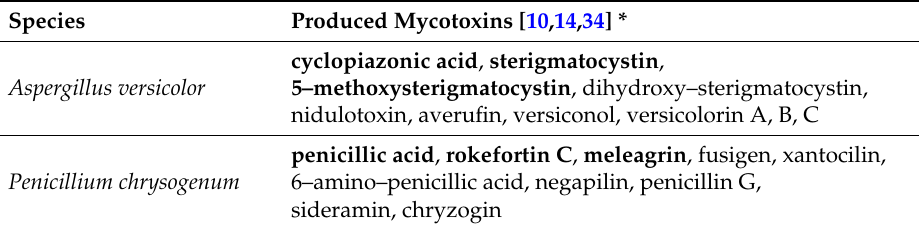
Table 5. Mycotoxins synthesised by selected moulds isolated from building partitions of analysed residential